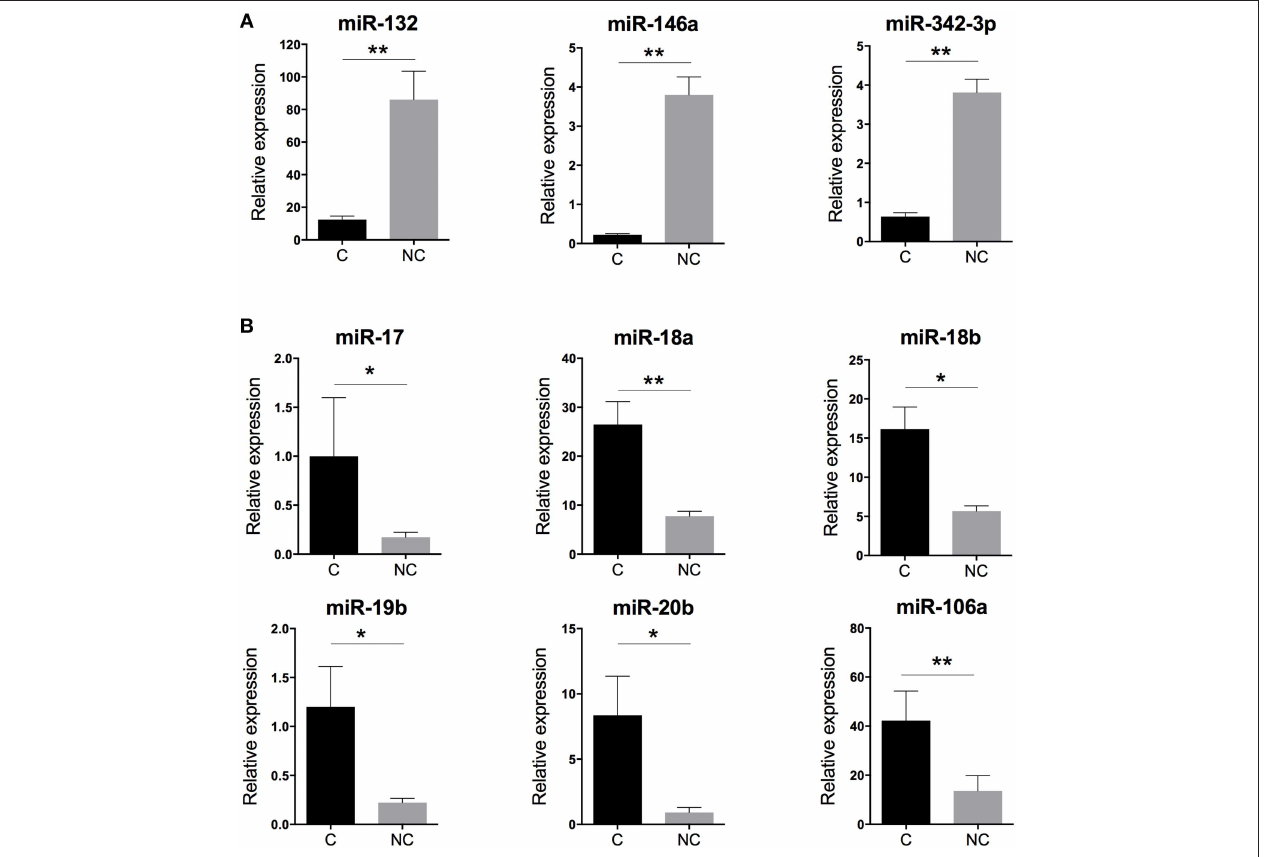
FIGURE 2 | Validation of the human monocyte subset-specific miRNA-based signature. Blood samples from healthy donors ( n = 7) were collected from the French Blood Establishment (EFS). After Ficoll-Paque density gradient, classical (C) CD14 ++ CD16 − and non-classical (NC) CD14 + CD16 ++ monocyte subsets were FACS sorted with > 97% purity (Montpellier RIO Cytometry platform). Total RNA was extracted from both monocyte subsets by using a miRNeasy kit and the automatized QIAcube procedure (QIAGEN). MiRNA expression was quantified by using multiplexed TaqMan RT-qPCR (Life Technology). (A) Quantification of the three miRNAs overexpressed in non-classical vs. classical monocytes. (B) Quantification of the six miRNAs overexpressed in classical vs. non-classical monocytes. Data are mean ± SD and differences were compared by non-parametric Mann-Whitney test (* p < 0.05, ** p <